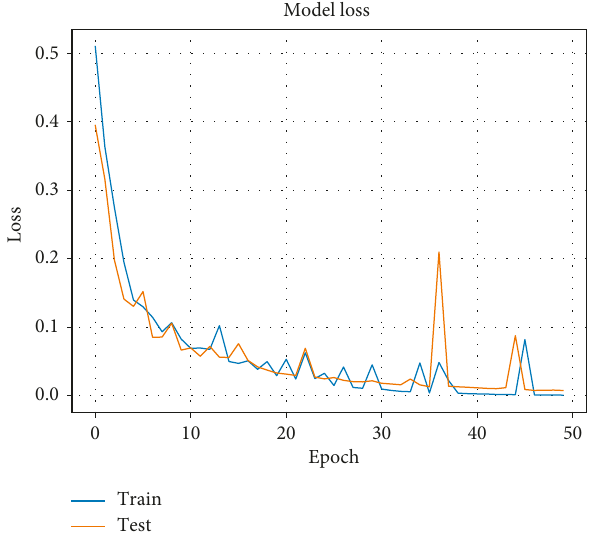
Figure 7: Loss change of training and testing data. Table 5: Accuracy of classification